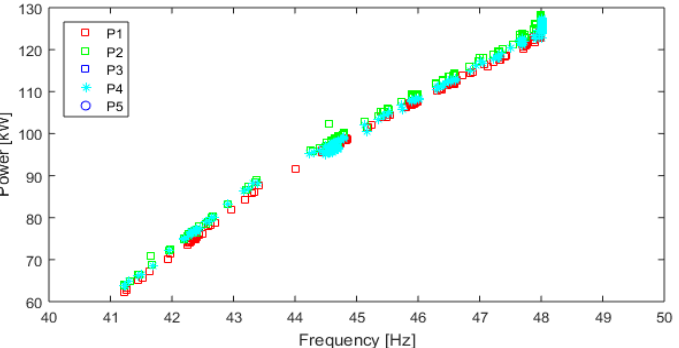
Figure 12. The characteristic F = f ( P i ) for the hydraulic regime with three pumps in operation.